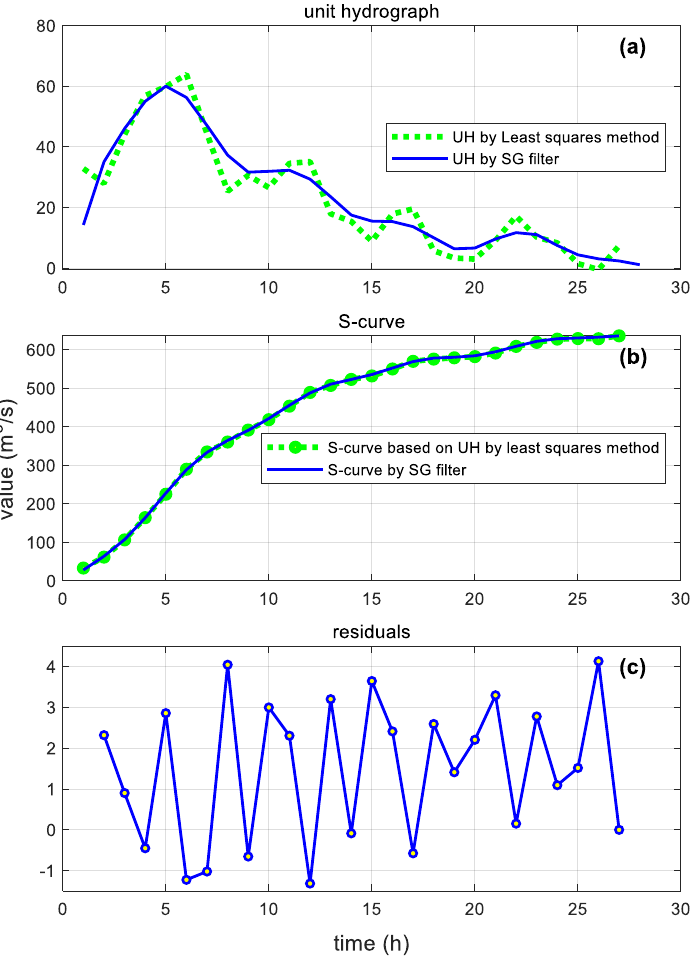
Figure 2. Hydrographs and S-curves by OLS and the SG filter (in the Almond and Almondell ba- sin): ( a ) unit hydrographs before and after the application of the SG filter; ( b ) S-curves before and after the application of the SG filter; ( c ) difference between S-curve ordinates after the application of the SG filter.